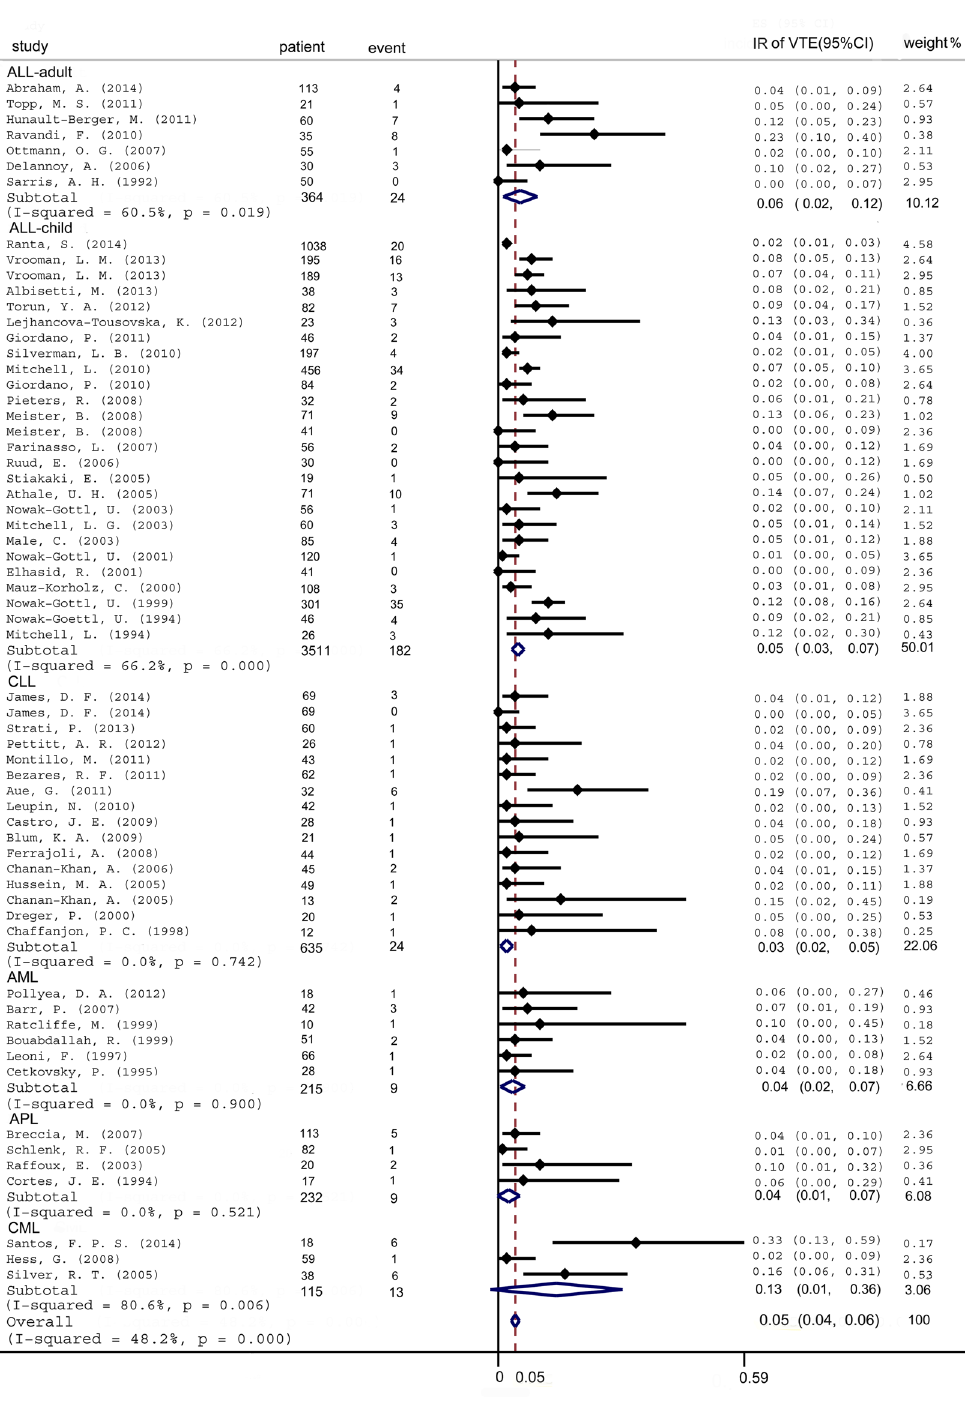
Figure 3. Forest plot of the risk of VTE in participants stratified by leukemia subtype. Random effects meta- analysis showing individual and pooled weighted incidence of leukemia-related VTE in studies, stratified by ALL-adult, ALL-child, CLL, AML, APL, and CML. ALL = acute lymphoblastic leukemia. CLL = chronic lymphoblastic leukemia. AML = acute myeloid leukemia. CML = chronic myeloid leukemia. APL = acute promyelocytic leukemia. IR = incidence rate. VTE = venous